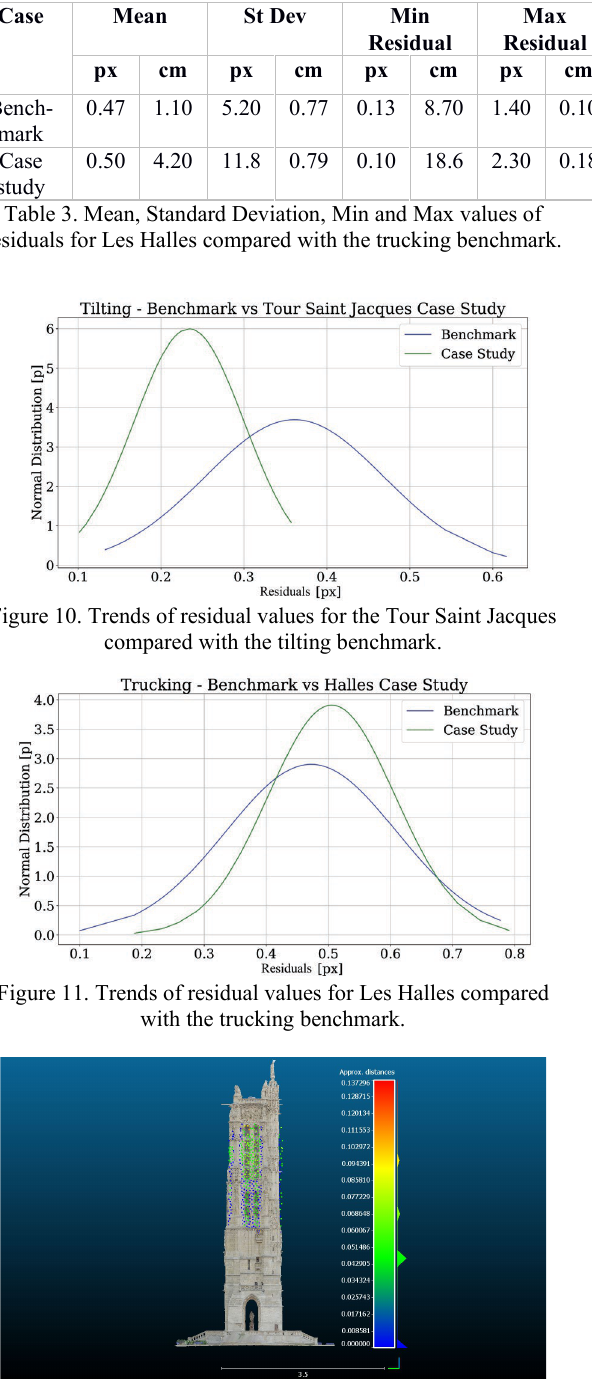
Figure 12. Metric comparison between point cloud of the tower obtained from film footage and from a recent